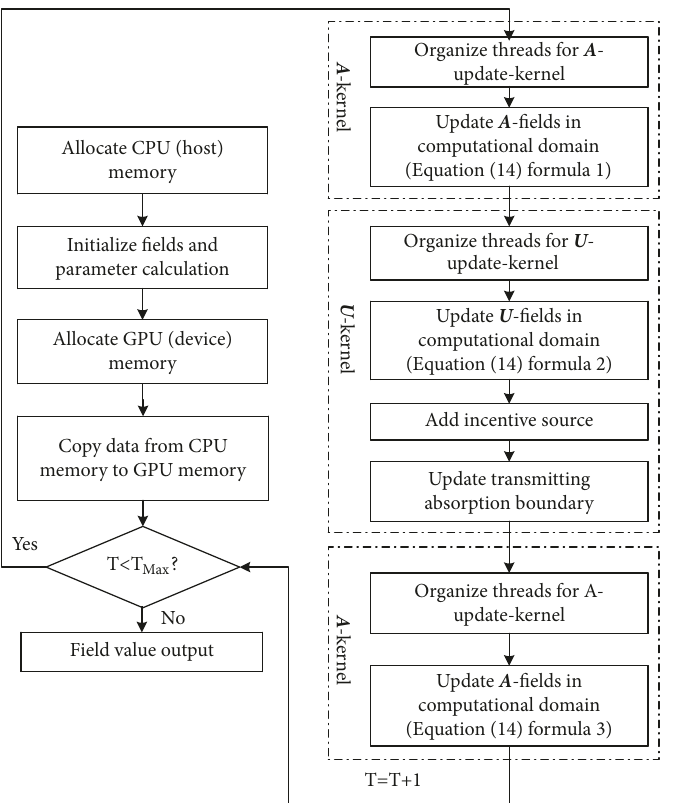
Figure 6: A flowchart showing the CUDA implementation of the conformal symplectic partitioned Runge-Kutta methods for determining the field